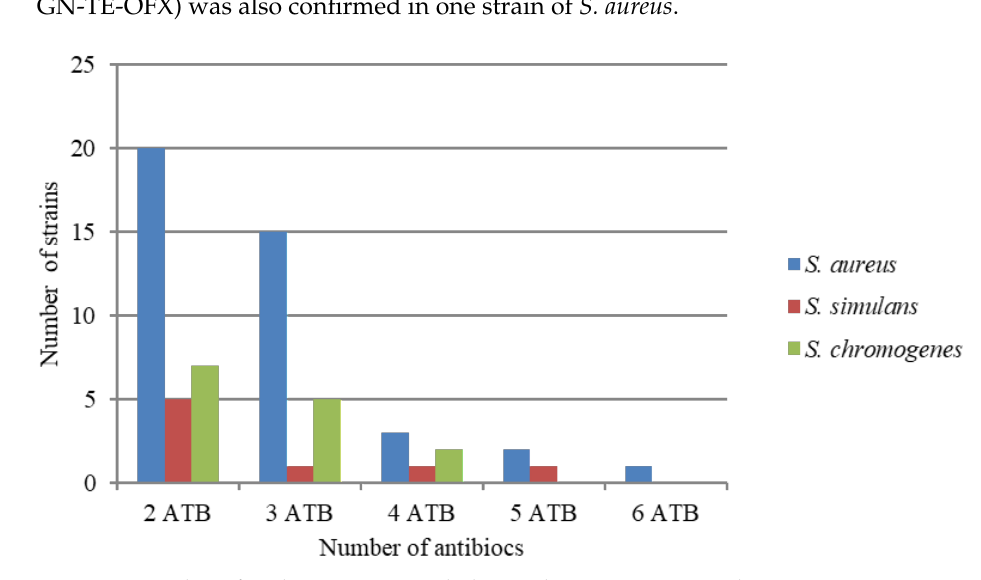
Figure 1. Number of multiresistance staphylococcal strains. ATB — antibiotics.